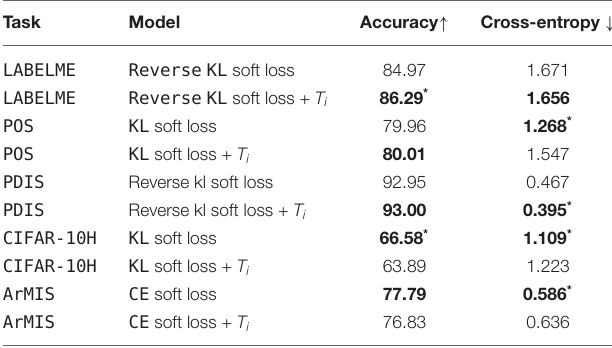
TABLE 2 | Results showing the accuracy (higher is better) and cross-entropy (lower is better) of soft loss models with and without